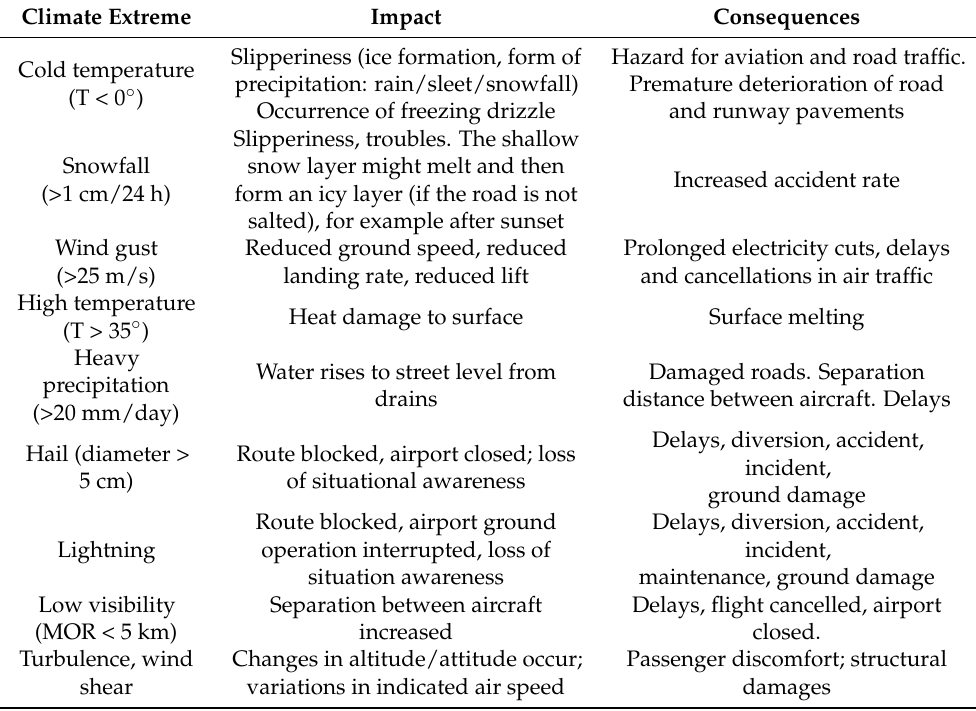
Table 1. A summary of relevant climate extremes, impacts, and related consequences for the area of Napoli Capodichino